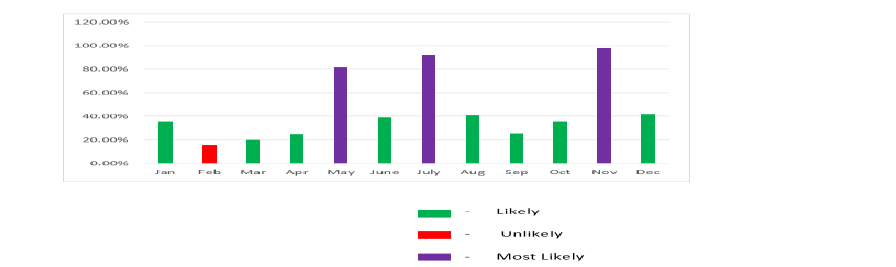
Table 2: Weather Event prediction – A Monthly